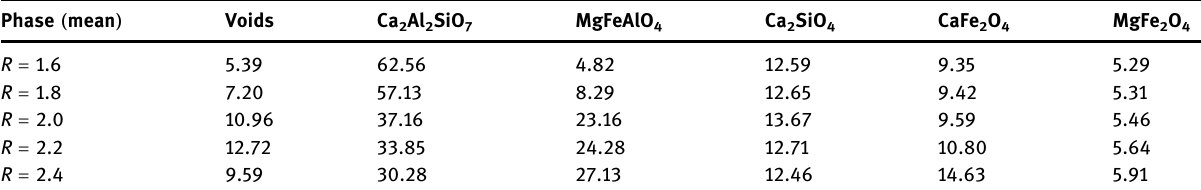
Table 8: Test results of phase composition and content of mixed slag with Basicity R = 1.6 – 2.4 wt% Phase ( mean